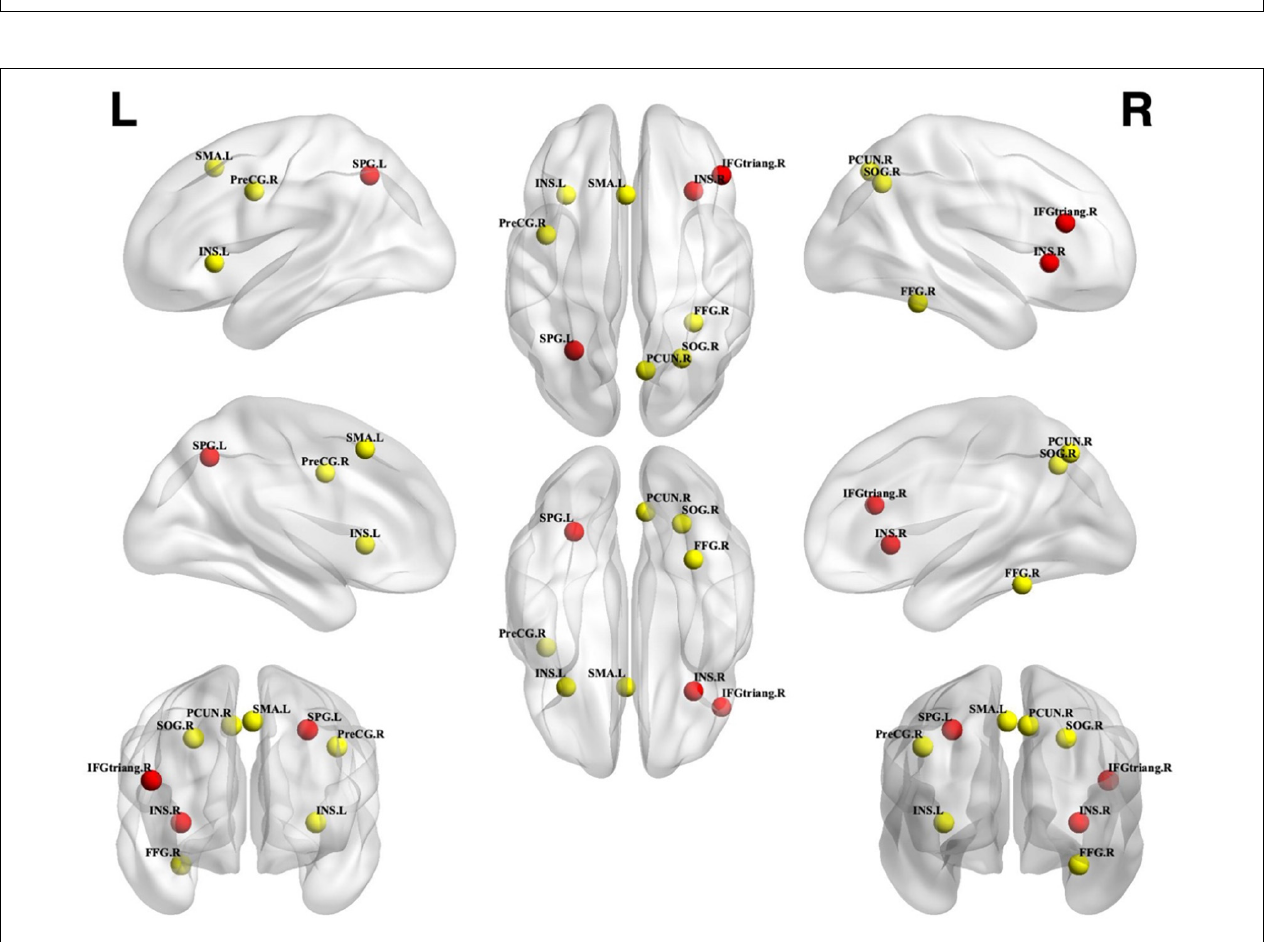
FIGURE 2 | Unconscious perceptual processing. Unconscious activation greater than baseline. Spheres with a radius of 5 mm are visualized to present the statistical results of clusters formed. Red spheres represent results that survived FWE correction, while yellow spheres represent results that are uncorrected. SPG, Superior parietal gyrus; INS, Insular; IFGtriang, Inferior frontal gyrus triangular part; SMA, Supplementary motor area; PreCG, Precentral gyrus; SOG, Superior occipital gyrus; FFG, Fusiform gyrus; PCUN, Precuneus; L, left; R, right.